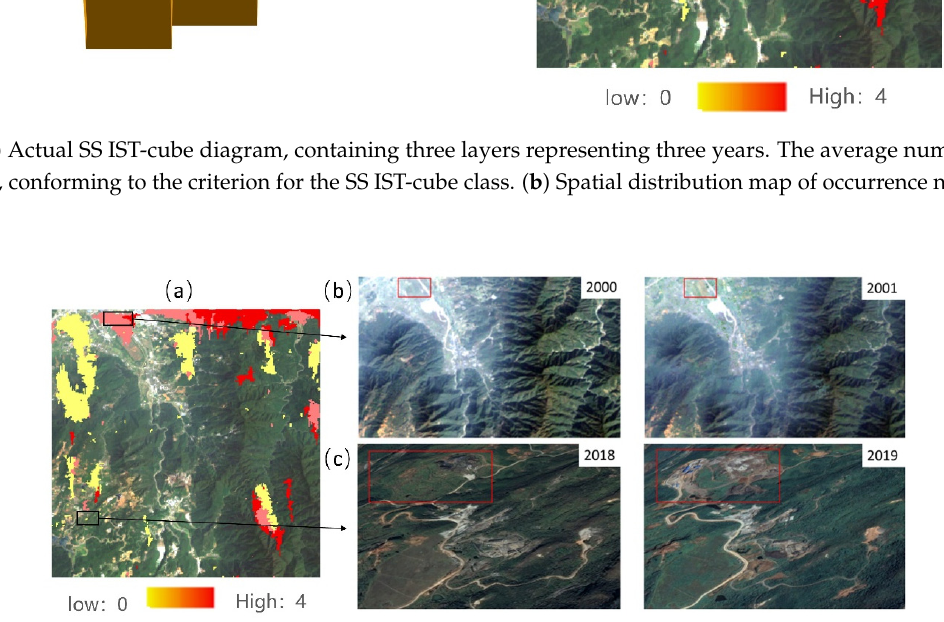
Figure 15. Assessment examples of SS change. ( a ) SS change in the study area (Figure 14b) with two marked examples of change. Images from Landsat and Google Earth show the changes before and after in the forests. ( b ) Land use change in 2001 and ( c ) land use change in 2019.